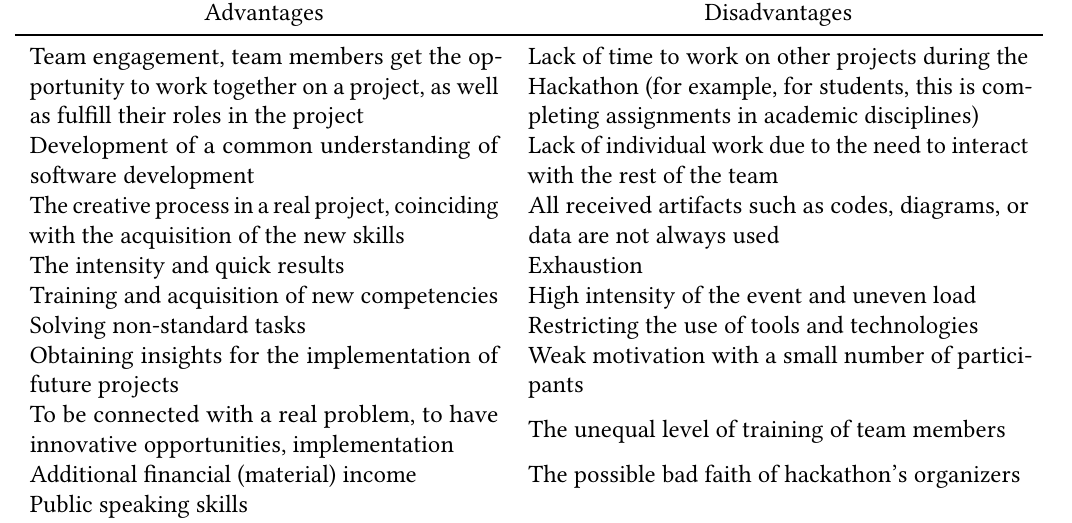
Some advantages and disadvantages of